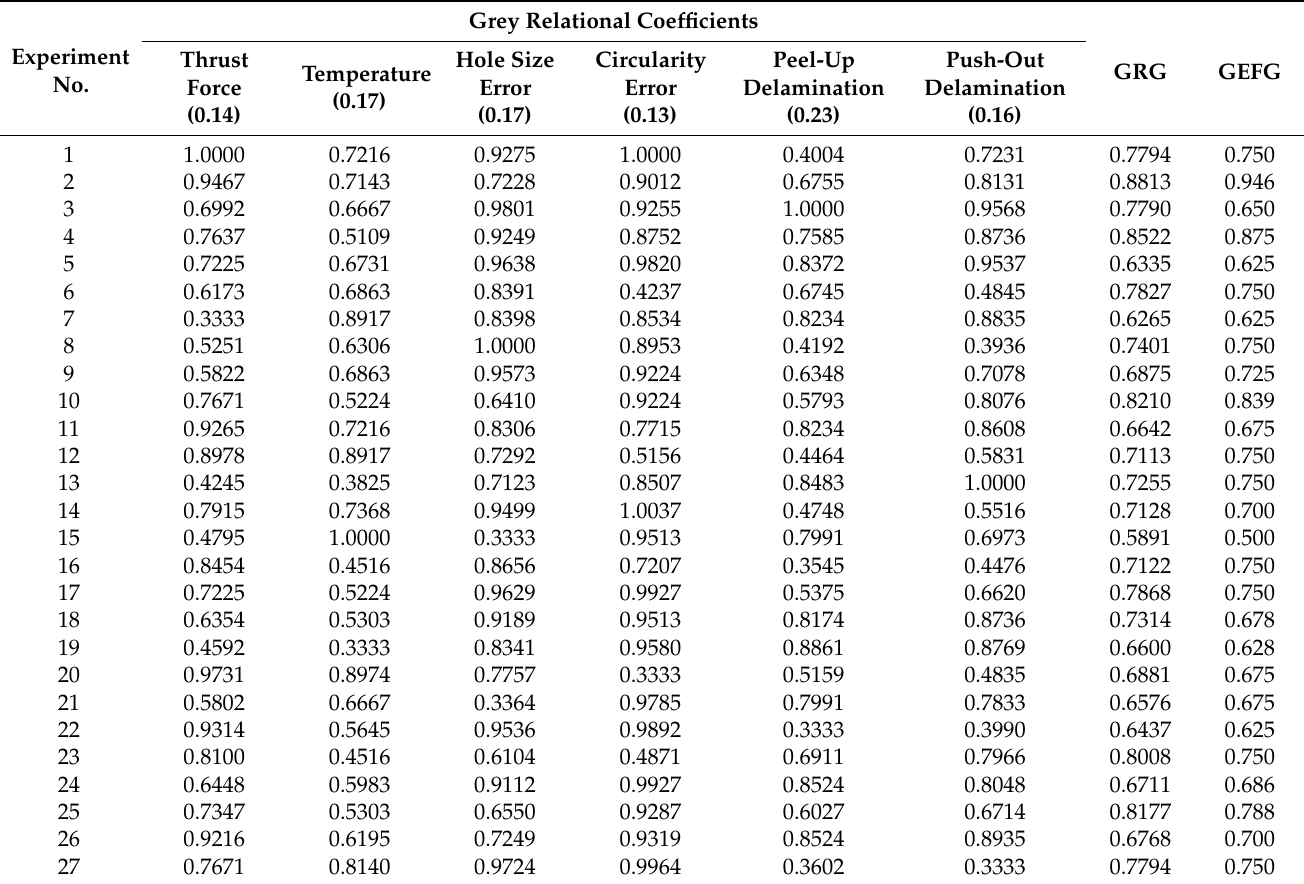
Table 8. Grey Relational Coefficients, Grey Relational Grade and Grey Entropy Fuzzy Grade